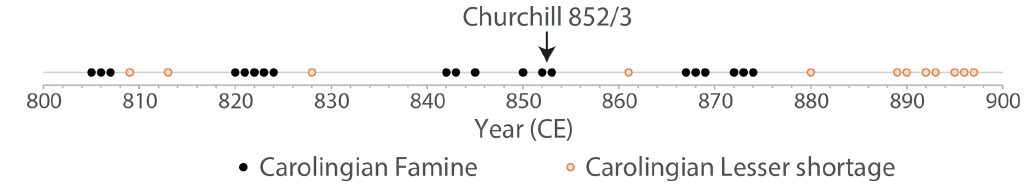
Figure 8. Ninth-century reports of large subsistence crises (“famines”, black) and seemingly more circumscribed crises (“lesser food short- ages”, orange) recorded in Carolingian sources (Newfield, 2013). Note again that the record of food shortages is imperfect: some crises may not have been recorded and the extent and severity of several recorded crises are difficult to